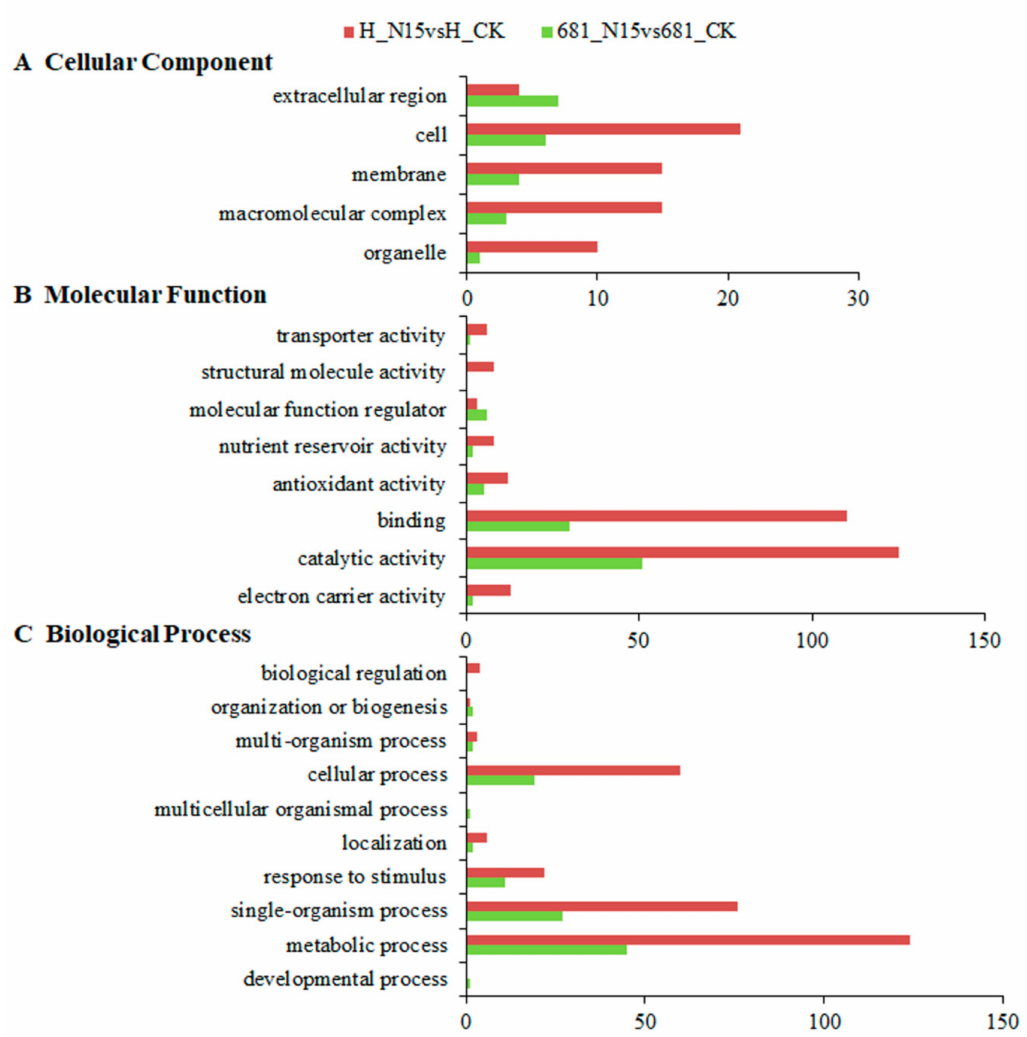
Figure 4. Statistical distribution chart of di ff erentially expressed proteins in the two rice cultivars roots under each Gene Ontology (GO) category ( 2nd Level). A. Cellular Component; B. Biological Process; C. Molecular Function. N15 represented rice under nitrogen fertilizer treatment with the concentration of while 225 kg / hm 2 , while control check (CK) represented the control without nitrogen fertilizer treatment; 681 and H represented Quanliangyou 681 and Huanghuazhan cultivars,